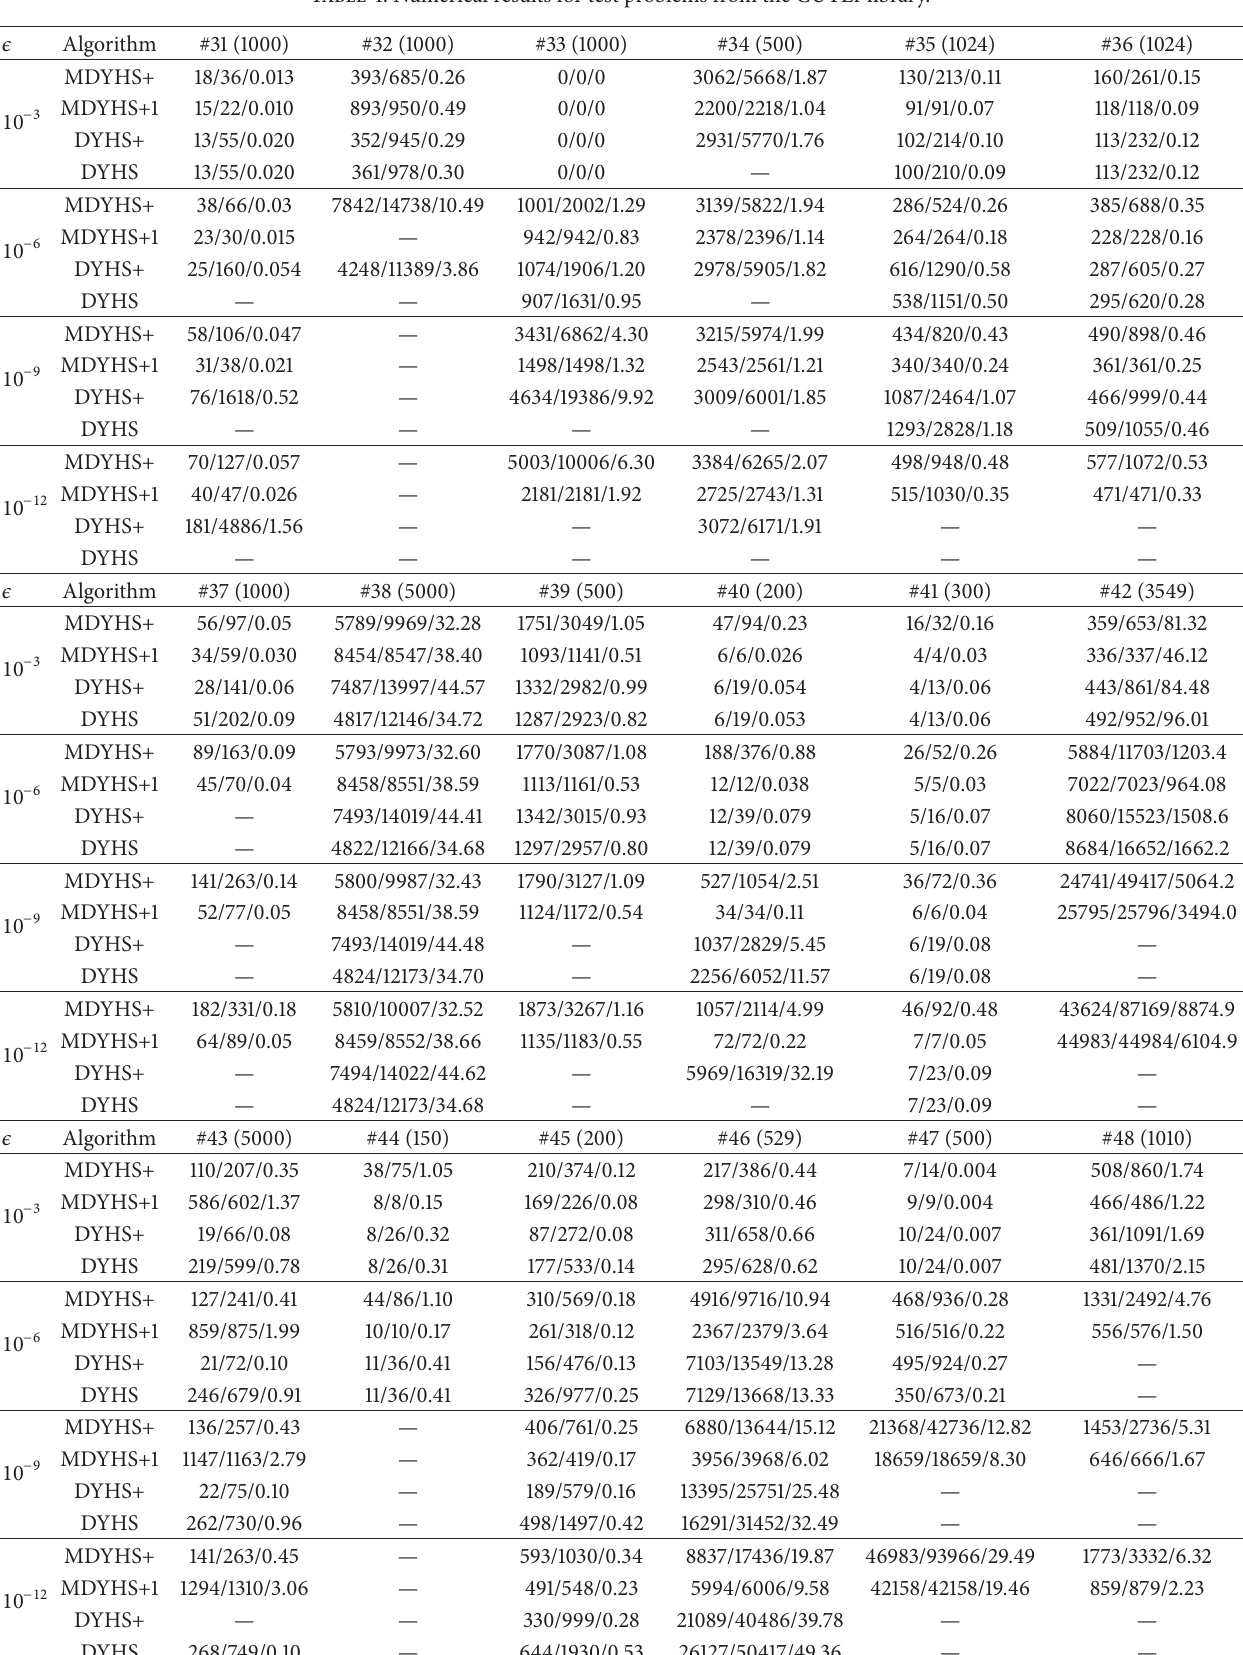
Table 4: Numerical results for test problems from the CUTEr